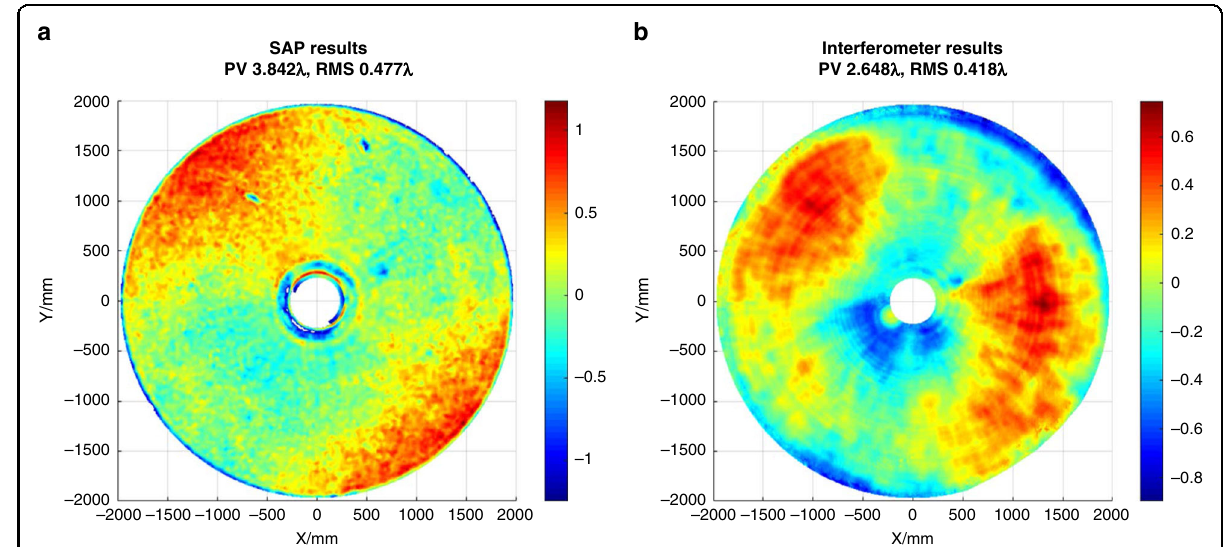
Fig. 17 Analysis of the ⌀ 4.03 m aspherical mirror SAP testing. a Test result by SAP. b Test result by interferometer